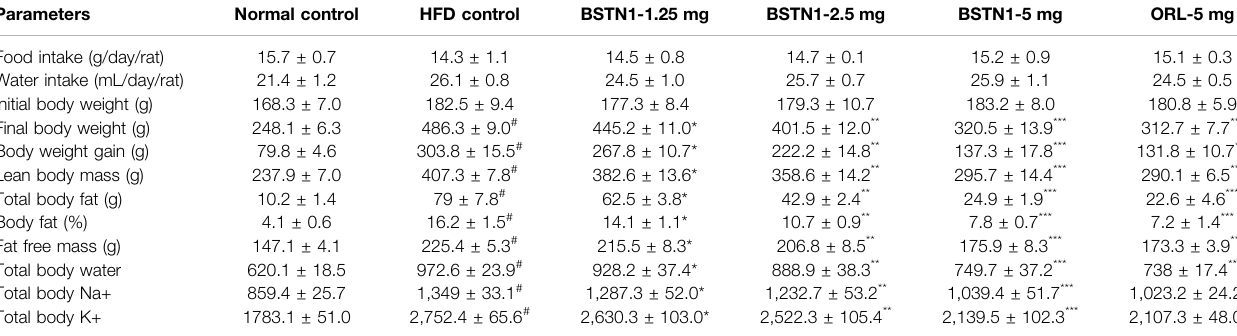
TABLE 1 | Effect of BSTN1 on food intake, water intake, body weight and body composition parameters of treated and untreated rats. Parameters